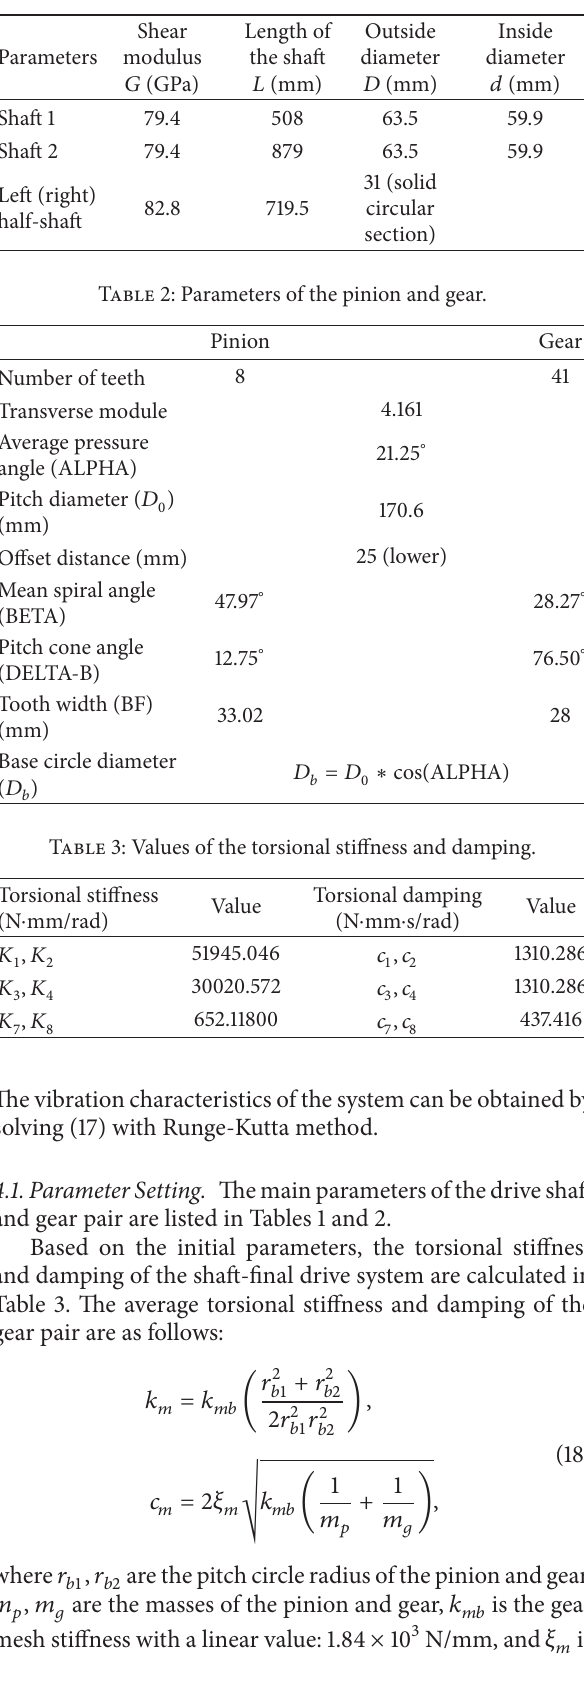
Table 1: Parameters of the drive shaft.